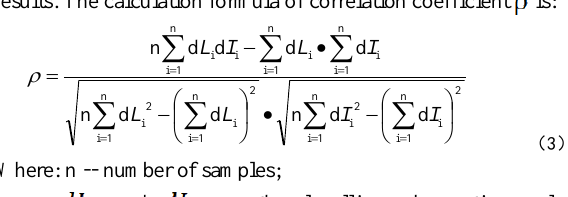
Figure 6. The Technical Route of Quality Inspection of the Mathematic